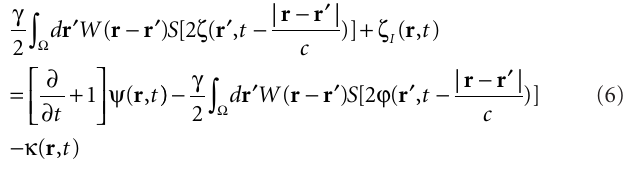
Figure 4 | Network activity (2D mapped to 1D) before (“control off”) and during (“control on”) closed-loop stimulation. “Pathological” 10 Hz oscillations of the recorded membrane potential (0–500 ms) are durably attenuated by the closed-loop stimulation signal (switched “on” between 500